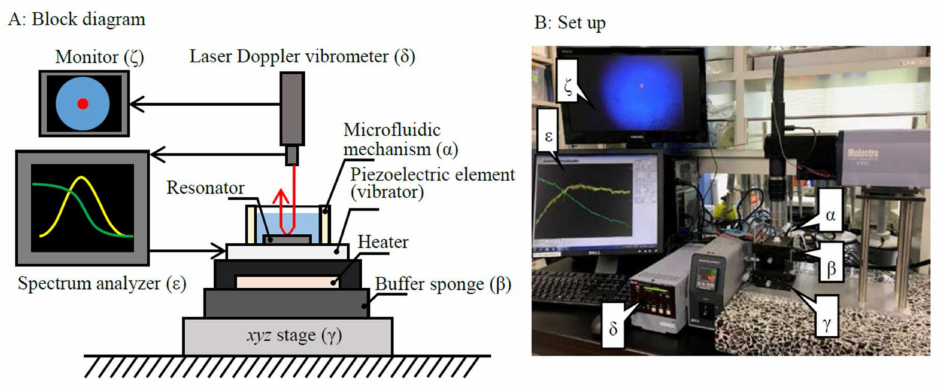
Figure 1. Block diagram of a line-free mass sensor and the resonance frequency measuring system. Electrical power is used to actuate the piezoelectric element, leaving the line-free mass sensor free from power